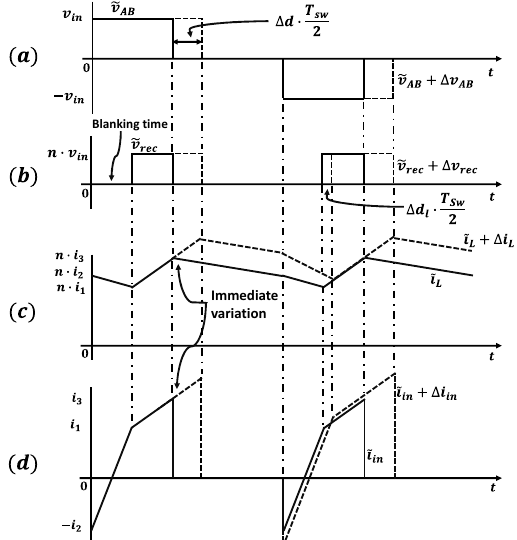
Figure 11. Dynamic response to a duty ratio step change. ( a ) Voltage at terminal A–B, ( b ) secondary voltage, ( c ) output inductor current and ( d ) input current.